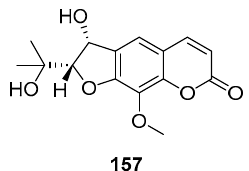
Figure 53. Coumarin derivative from Ainsliaea fragrans.